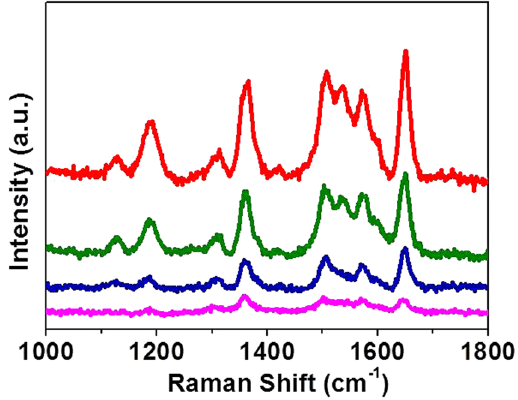
Figure 3. SERS spectra of 10 − 5 –10 − 8 M R6G on the AuNPs array. The incident laser of 633 nm was used with the laser power of 1 µ W and the laser diameter of 1 µ m focused on the samples. The acquisition time was 10 s.